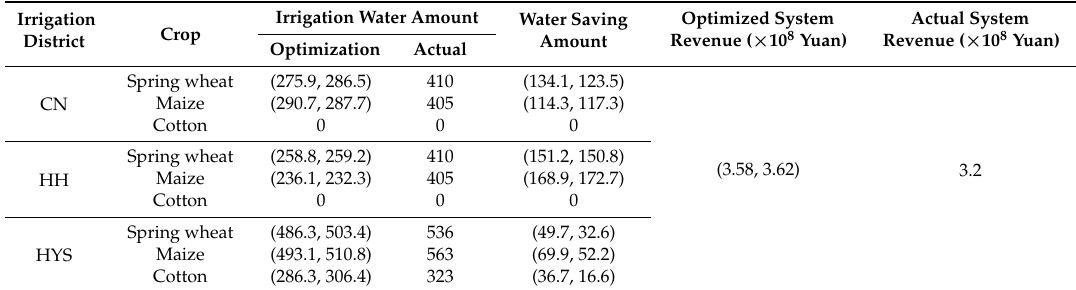
Table 5. Comparison of the results from optimal and actual irrigation water